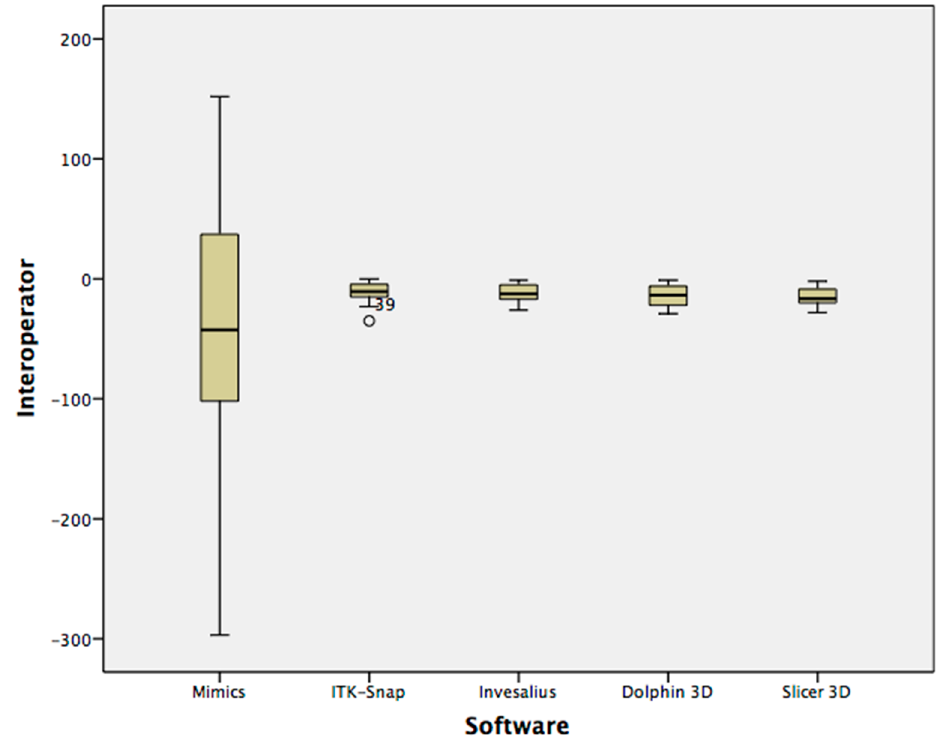
Figure 5. Box-Whisker plots of volumetric differences between first and second inter-operator readings.